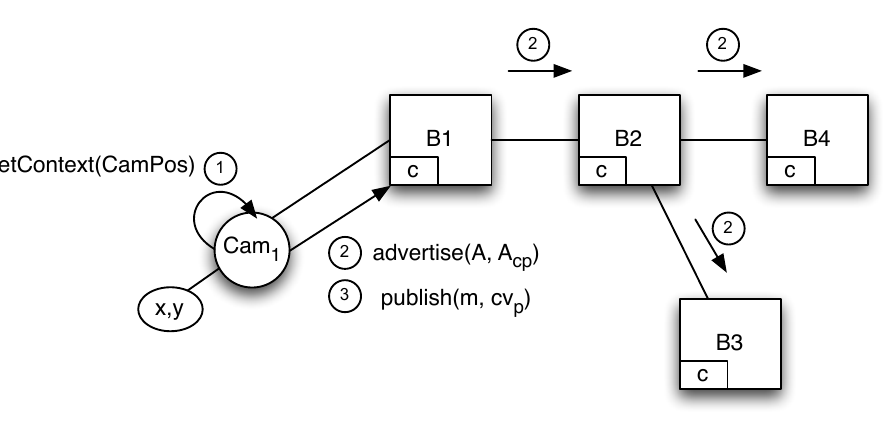
Figure 4. Adding a new publisher to the